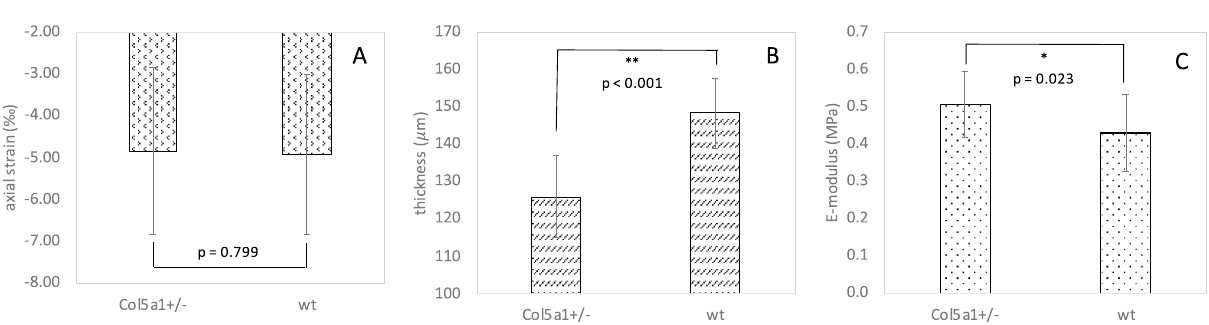
Figure 2. ( A ) Average induced axial corneal strain, ( B ) central corneal thickness and ( C ) E-modulus obtained from OCE in Col5a1 +/− eyes and wild-type eyes. * indicates statistical significance at p < 0.05, ** indicates statistical significance at p < 0.001. n = 14 per